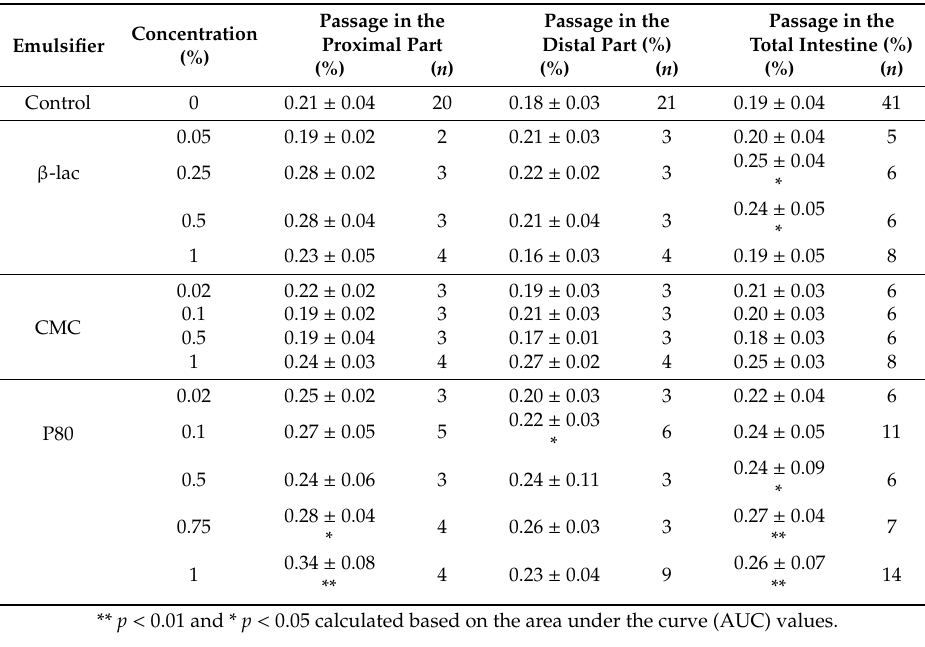
Table 1. The passage of the marker molecule mannitol in both the proximal part, the distal part, and the total (proximal and distal part together) small intestine at 120 min after the start of the experiment for the di ff erent emulsifiers at varying concentrations. The values are presented as the mean ± standard deviation together with the number of replicates ( n ). The p -values are calculated based on di ff erences in kinetics detected by the AUC analysis compared with the control.